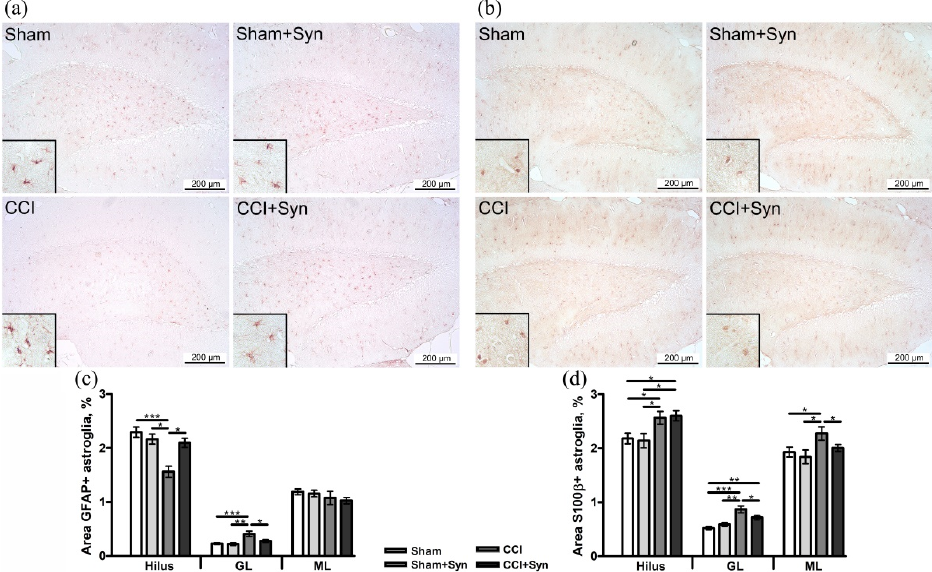
Figure 4. Effect of CCI and synaptamide treatment on hippocampal astroglial activity. Representative images of ( a ) GFAP and ( b ) S100 β immunostaining. Histogram demonstrating the % of ( c ) GFAP- and ( d ) S100 β -positive staining within the DG regions after the surgery and synaptamide treatment. Data are presented as mean ± SEM, n = 7/group, * p < 0.05, ** p < 0.01 and *** p < 0.001 (one-way ANOVA, post-test Tukey).